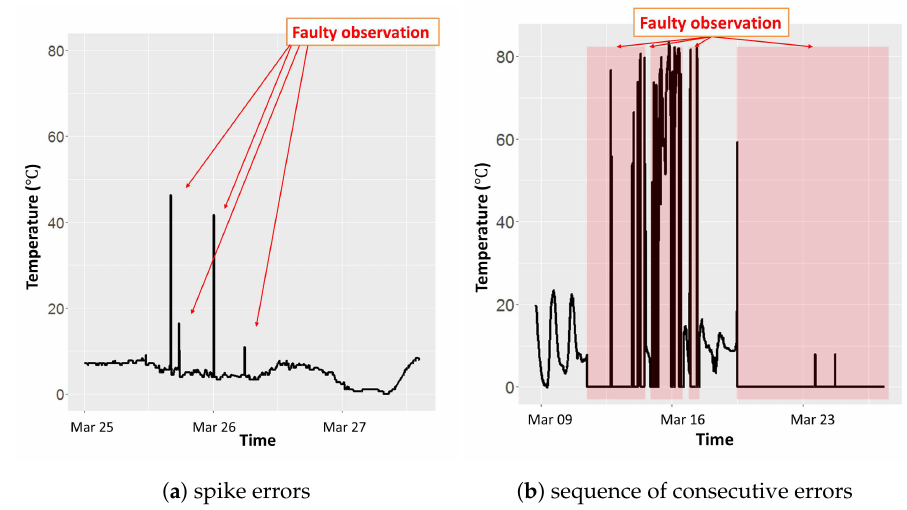
Figure 1. Examples of temperature sensor readings with faulty